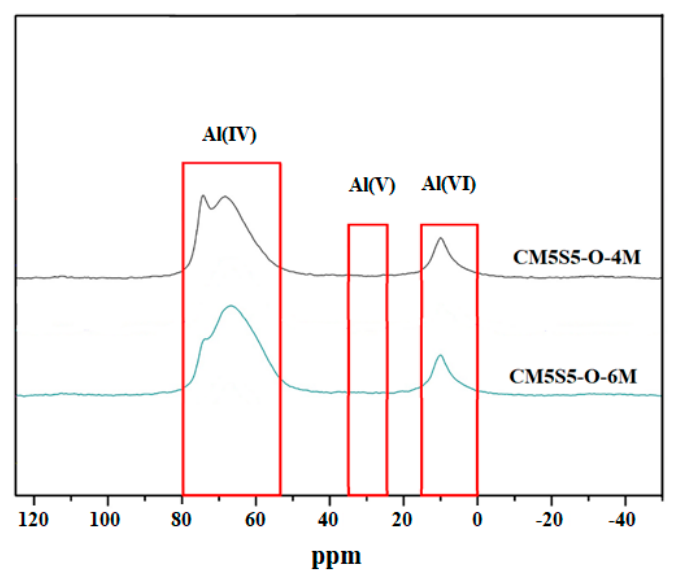
Figure 7. 27 Al NMR spectrum of marble-based geopolymer concrete.